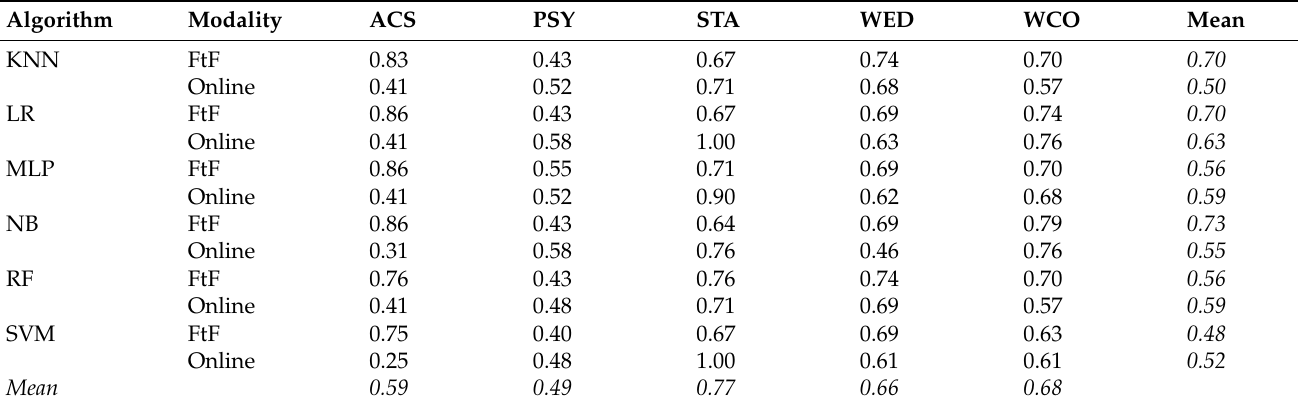
Table 2. Prediction of at-risk students (sensitivity scores) by instructional mode and